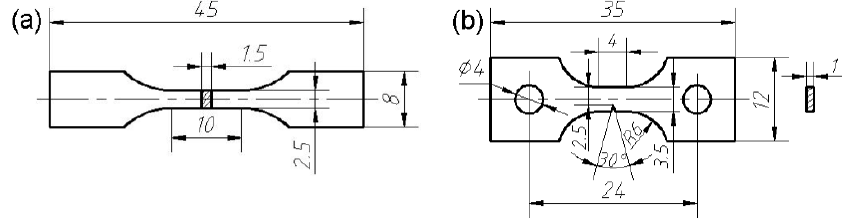
Figure 1. Dimensions of ( a ) tensile and ( b ) in situ tensile test specimens (in mm).